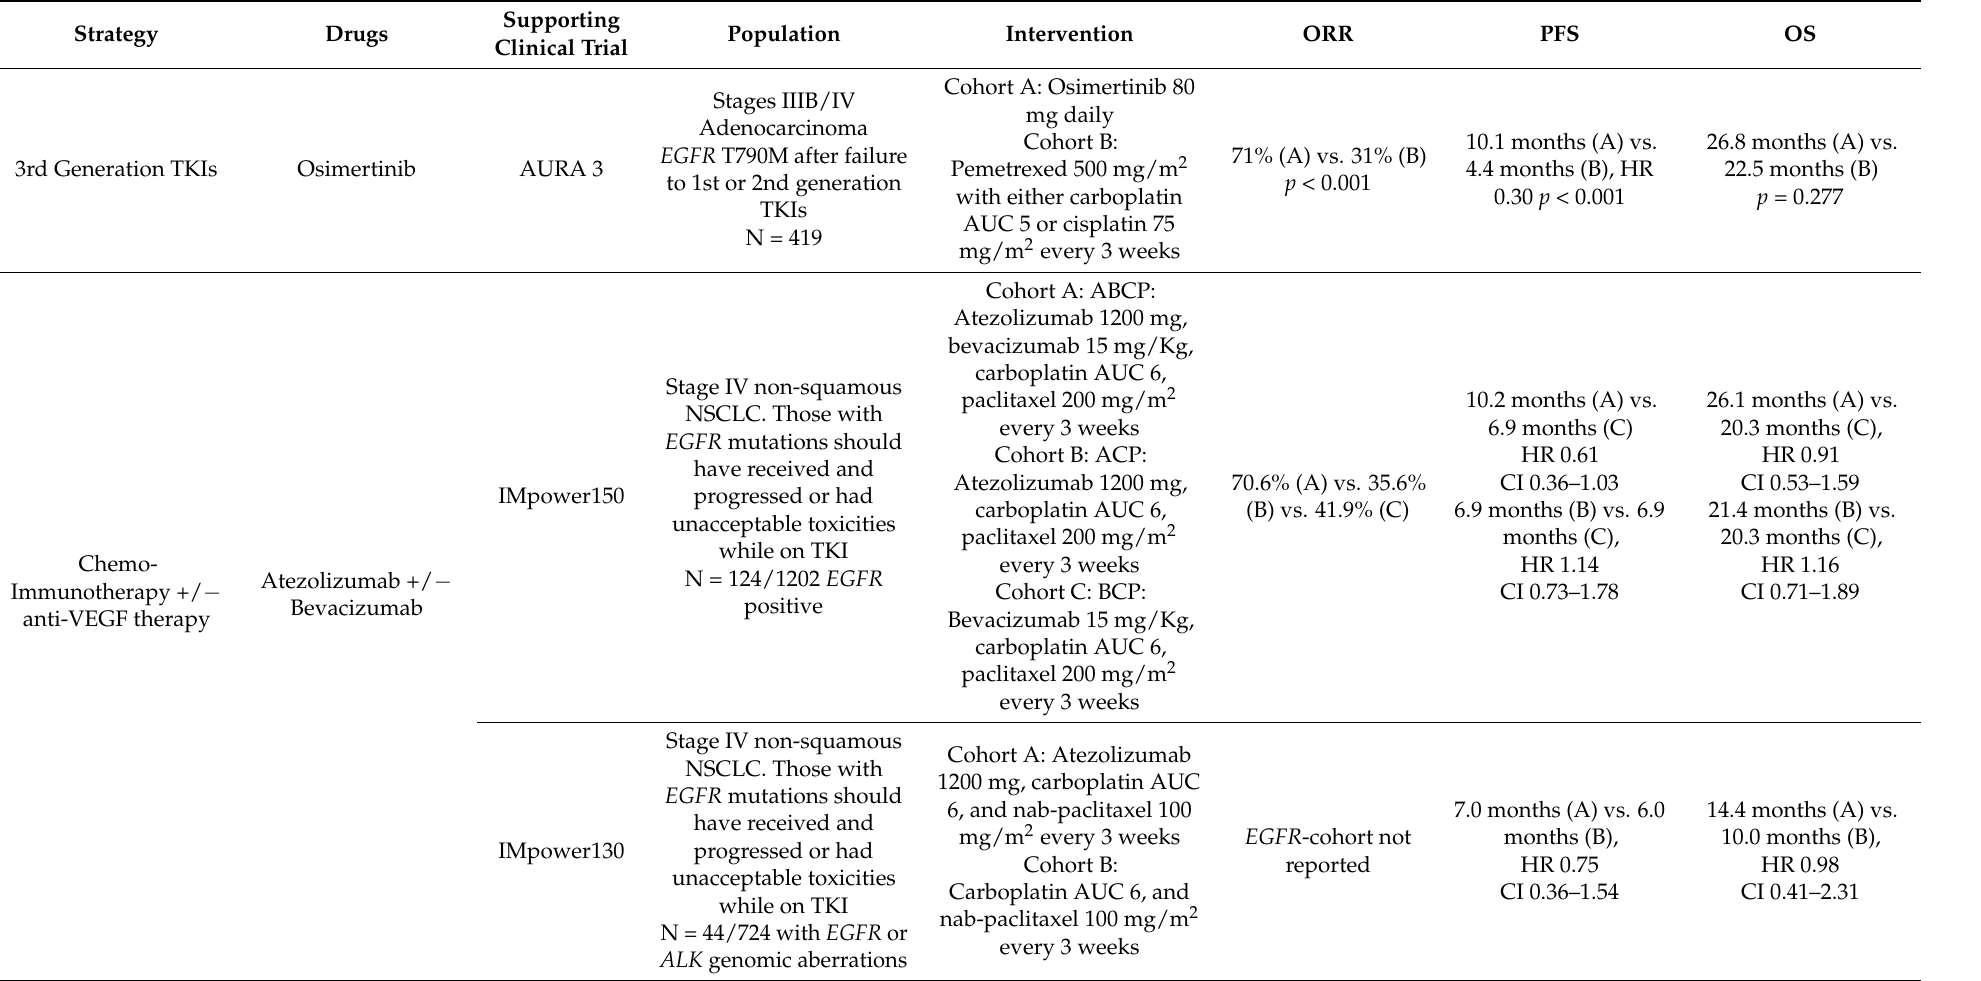
Table 3. Strategies to Overcome TKI